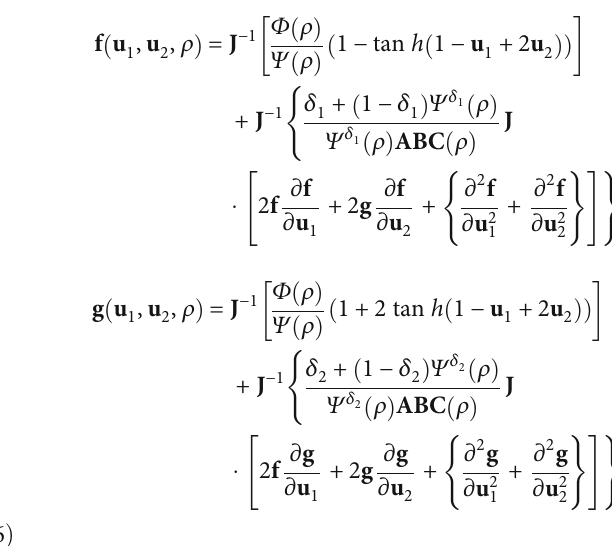
, u , t Þ and absolute 2